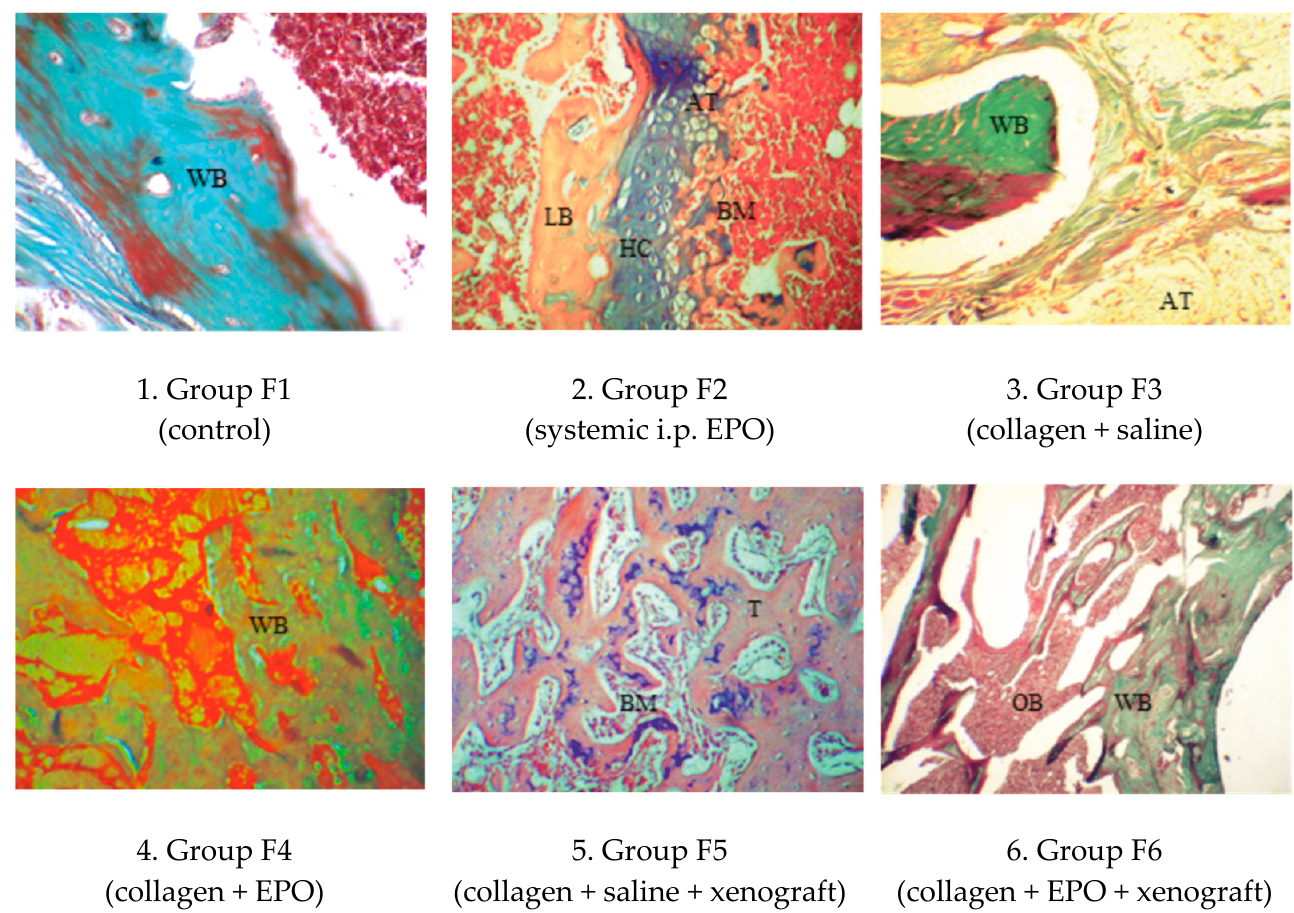
Figure 10. Histological patterns of rat femur segmental defects in different study groups on day 90. (1) Hyaline and fibrous cartilage transformation into lamellar bone with visible bone marrow spaces, MT × 125; (2) the bony and cartilaginous parts (HC) are adjacent to differentiating red bone marrow (BM) and white adipose tissue, H&E × 125; (3) woven bone (WB), surrounded by amorphous substance, cells and adipose tissue (AT), MT × 100; (4) woven bone (WB) undergoing transformation into lamellar bone, MT × 100; (5) trabeculae and bone marrow, H&E × 120; (6) all cavities demonstrate transformation of cartilage into bone tissue, MT ×